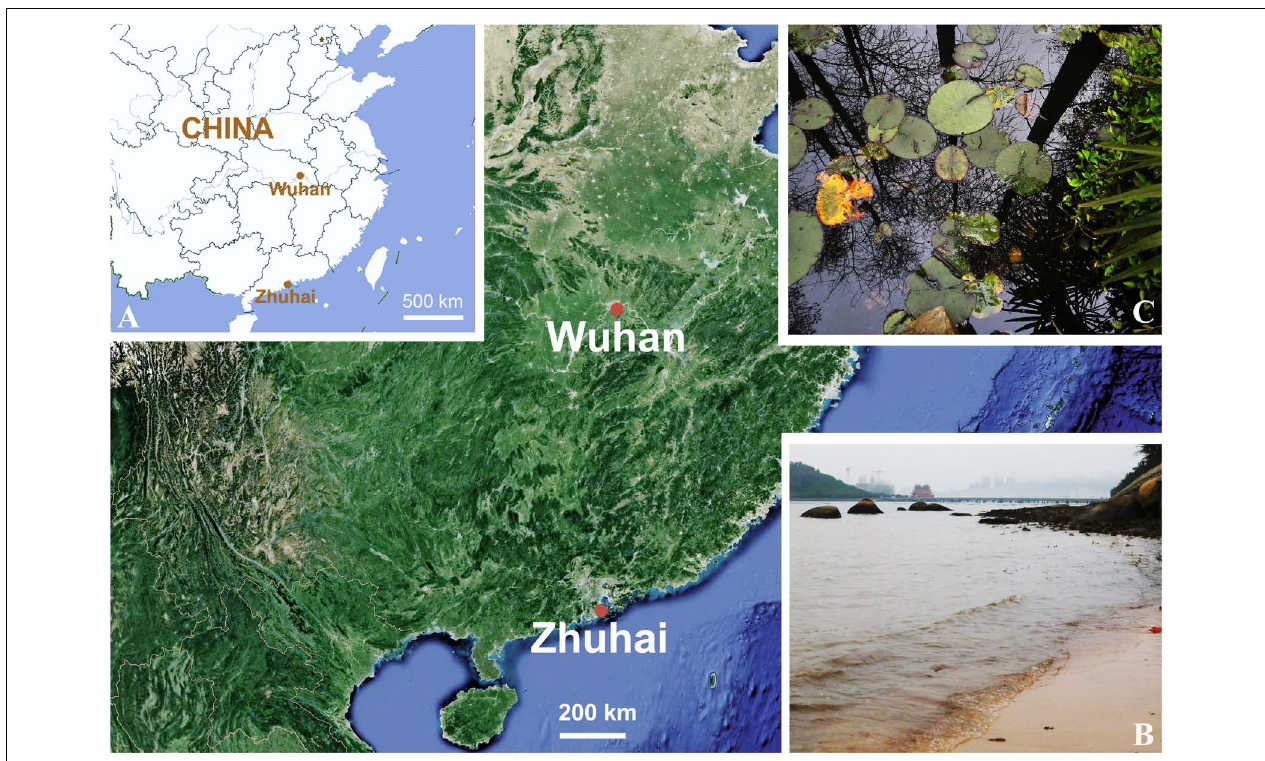
FIGURE 1 | (A–C) Locations and photographs of the sampling sites. (A) Locations of the sampling sites, marked with red dots. (B) Sandy beach near Zhuhai Fishing Girl Statue (22 ◦ 15 (cid:48) 41 (cid:48)(cid:48) N; 113 ◦ 35 (cid:48) 16 (cid:48)(cid:48) E). (C) Freshwater pond in Wuhan Botanical Garden, Chinese Academy of Sciences (30 ◦ 32 (cid:48) 57 (cid:48)(cid:48) N; 114 ◦ 25 (cid:48) 51 (cid:48)(cid:48)